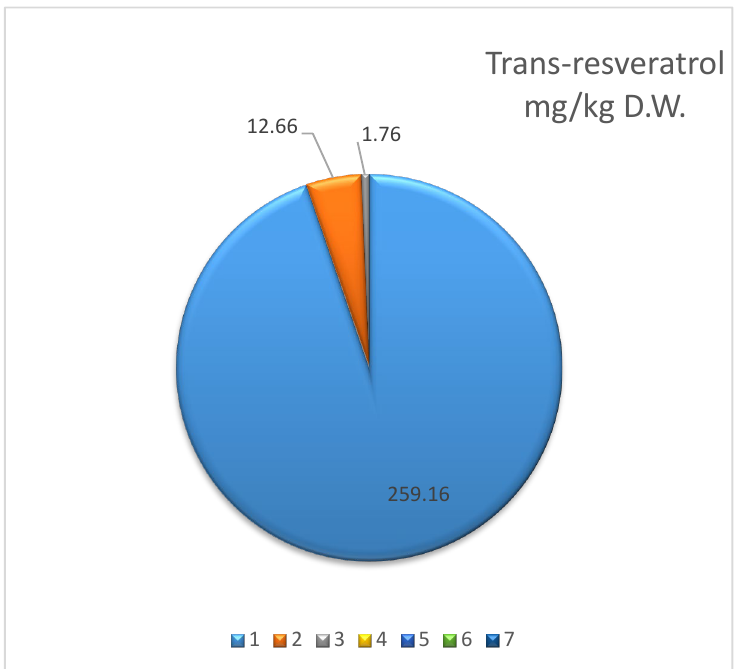
Figure 5. Types of granulosity.